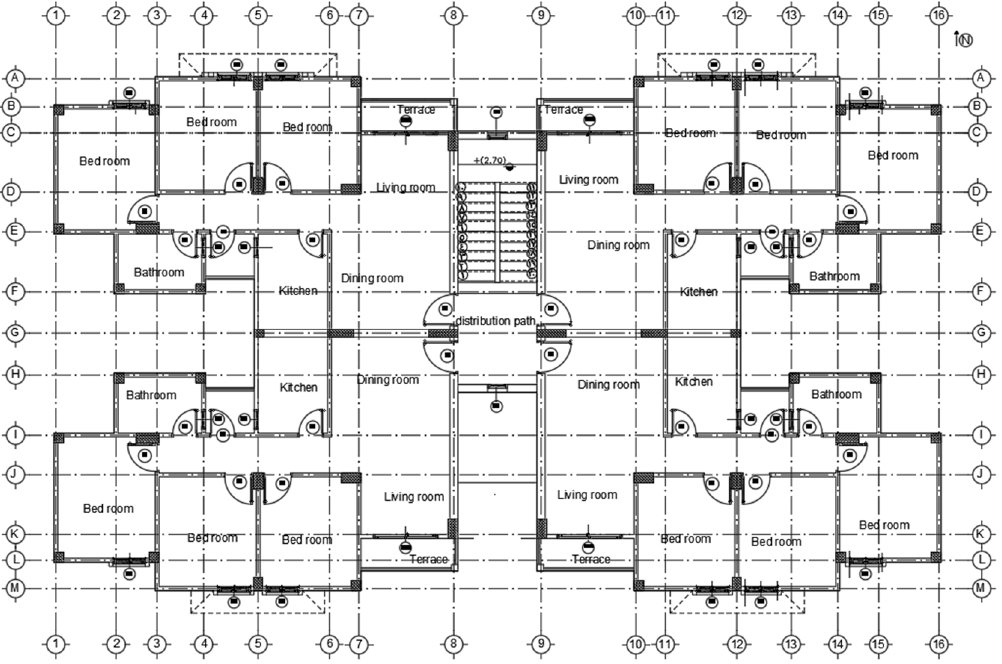
Figure 2. Pictures from the project site; ( a ) A picture showing the scale of the project; ( b ) A picture showing the East façade of a typical building.